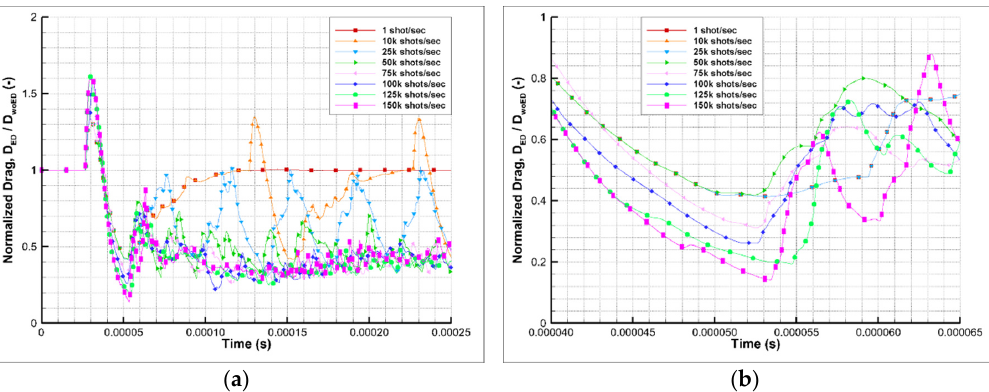
Figure 7. Normalized drag vs. time for different deposition frequency ( a ) entire simulation time, left; ( b ) around the first drag reduction only (enlarged view), right.